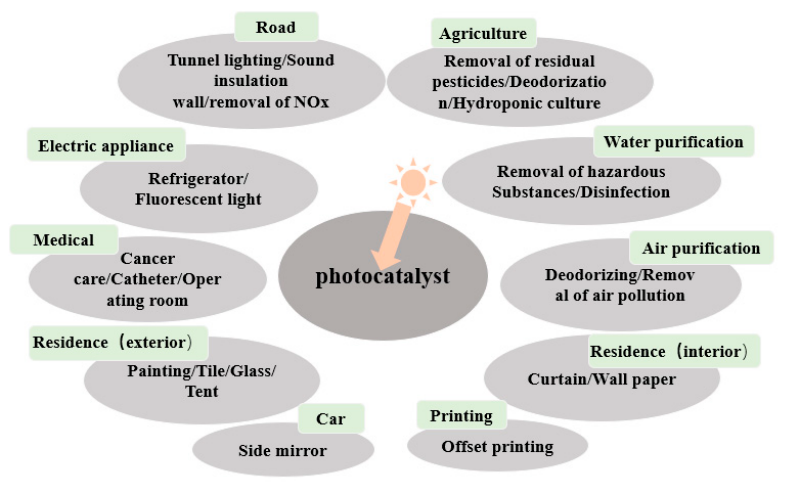
Figure 16. Applications of semiconductor photocatalysis.